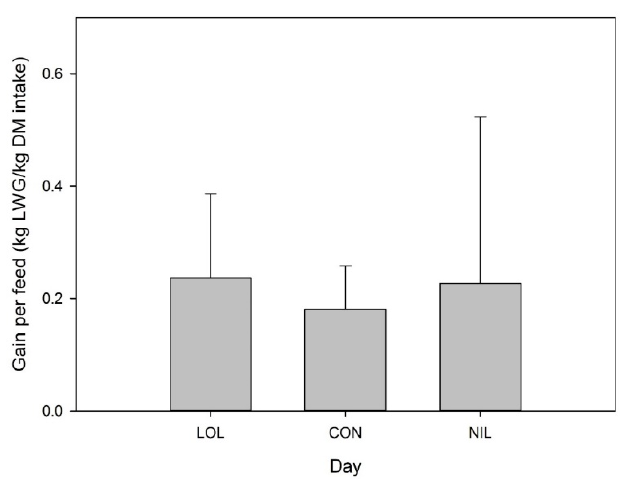
Figure 5. Average growth efficiency over the 28 day trial measured as gain per feed (kg LWG/kg DM intake) of lambs with mixed parasite infection treated with a meadow fescue seed extract with (LOL) or without loline (NIL), or non-treated (CON) .